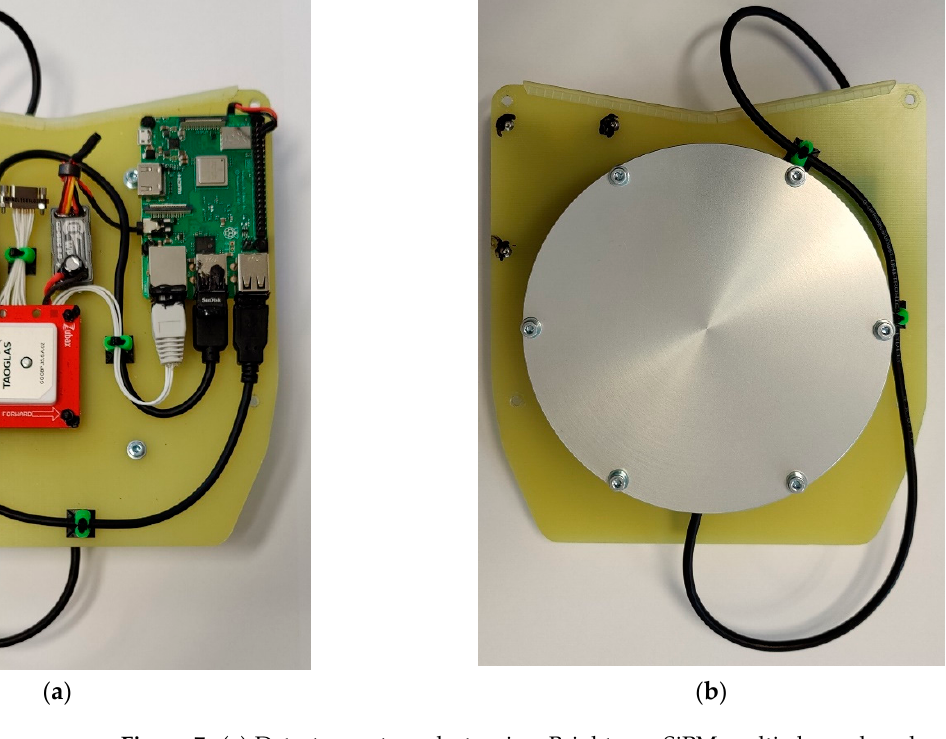
Figure 7. ( a ) Detector system electronics. Brightspec SiPM multi-channel analyzer (blue), Zubax GNSS 2.0 (red), Raspberry Pi 3 B+ (green), BEC 2.0 DC-DC converter (grey). ( b ) Scionix CsI detector with SiPMs and aluminum housing.